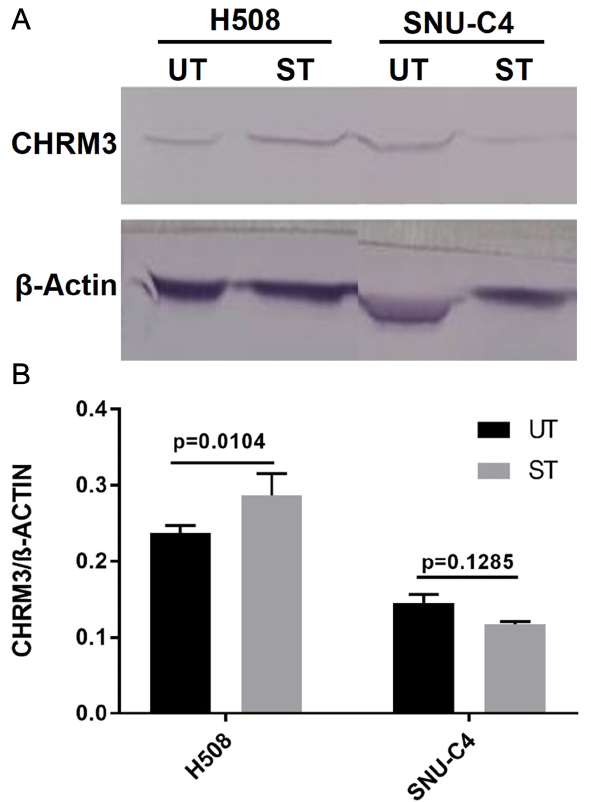
Figure 5. (A) Effects of ST on expression of CHRM3 of H508 and SNU-C4 human colon cancer cells. UT, Untreated. Specific protein bands detected by western blots were quantified using ImageJ software and normalized against β -actin. (B) Relative quantification of Western blot analysis is depicted in the bar graphs. Statistical analysis was performed with 2-way ANOVA with Sidak’s post hoc test for multiple comparisons. Values represent mean ± S.E.M (n = 3). ANOVA, analysis of variance; SEM, standard error of